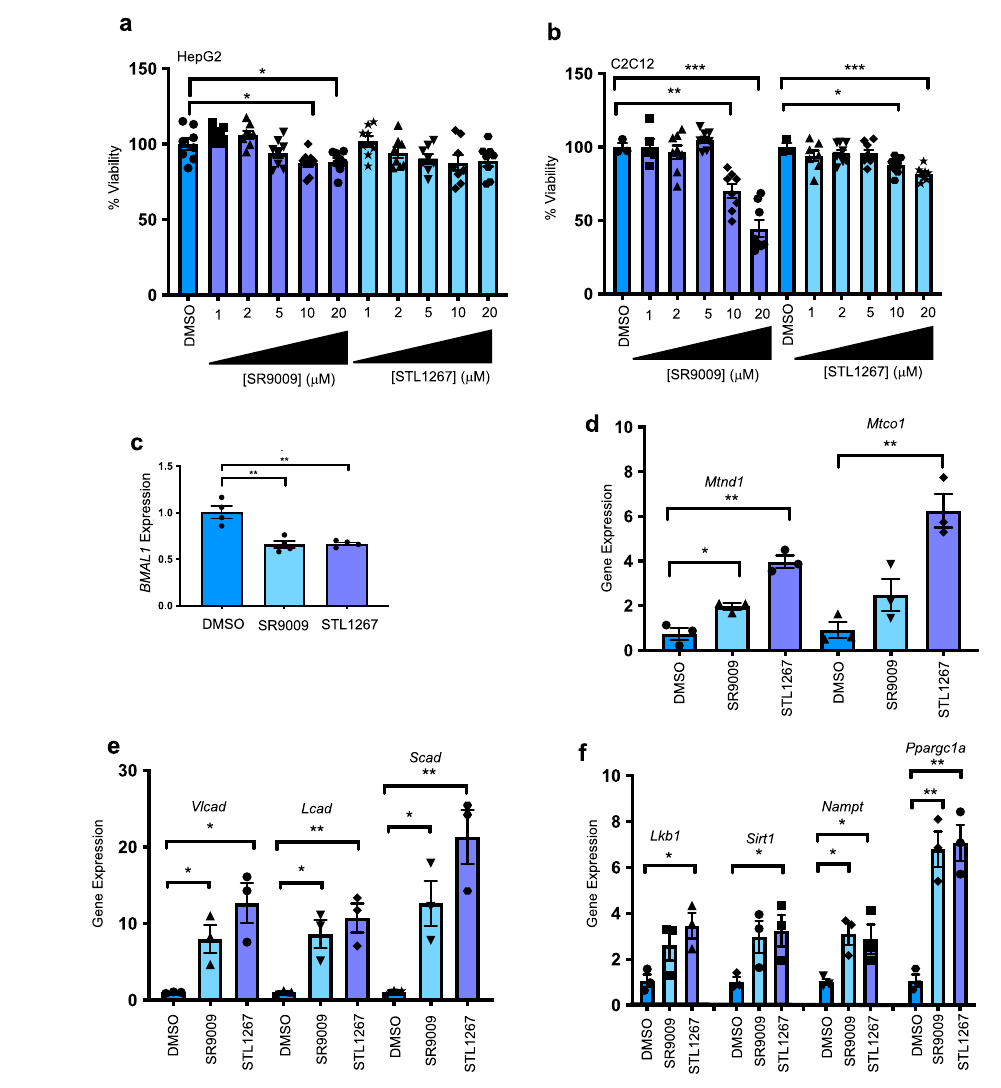
( d ), fatty acid oxidation ( Vlcad – DMSO vs. SR9009 P =0.062 and vs. STL1267 ( f ).* P <0.05,** P <0.01,*** P <0.001and **** P <0.0001vsDMSOorvehiclecontrol by one-way ANOVA followed by Dunnett ’ s post hoc test. Data are presented